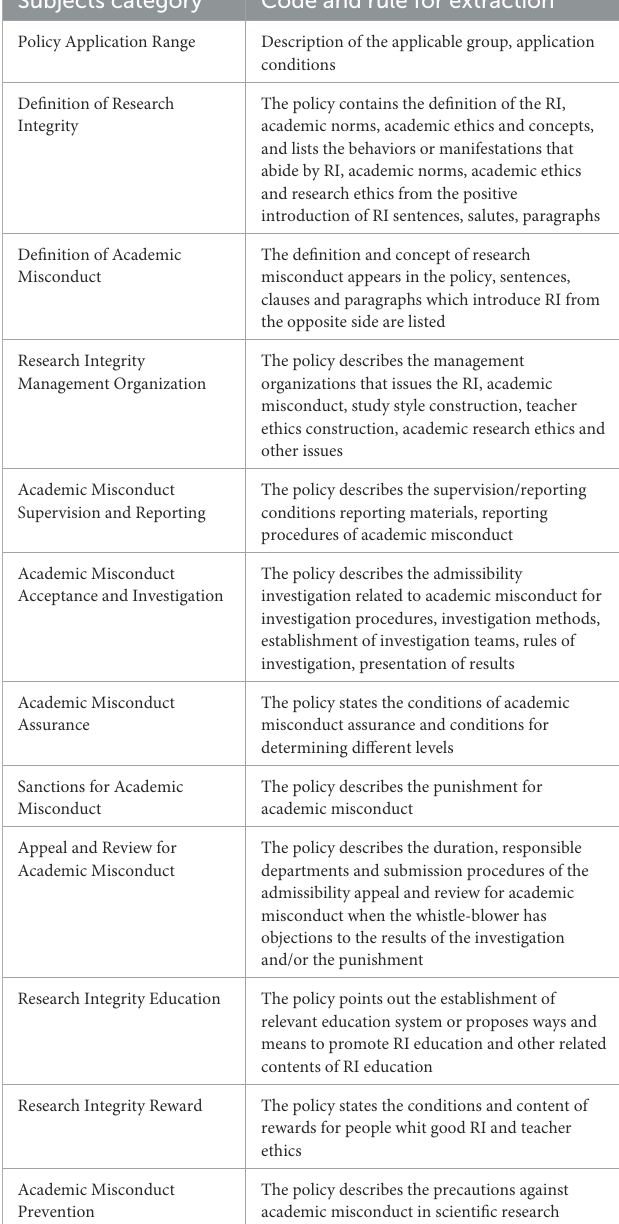
TABLE 4 Characteristics of clustering results of RI policy themes in higher TABLE 5 Code and rule for extracted the subject category used to describe education institutions. the RI Cluster Size Isim Descriptive Discriminating features features